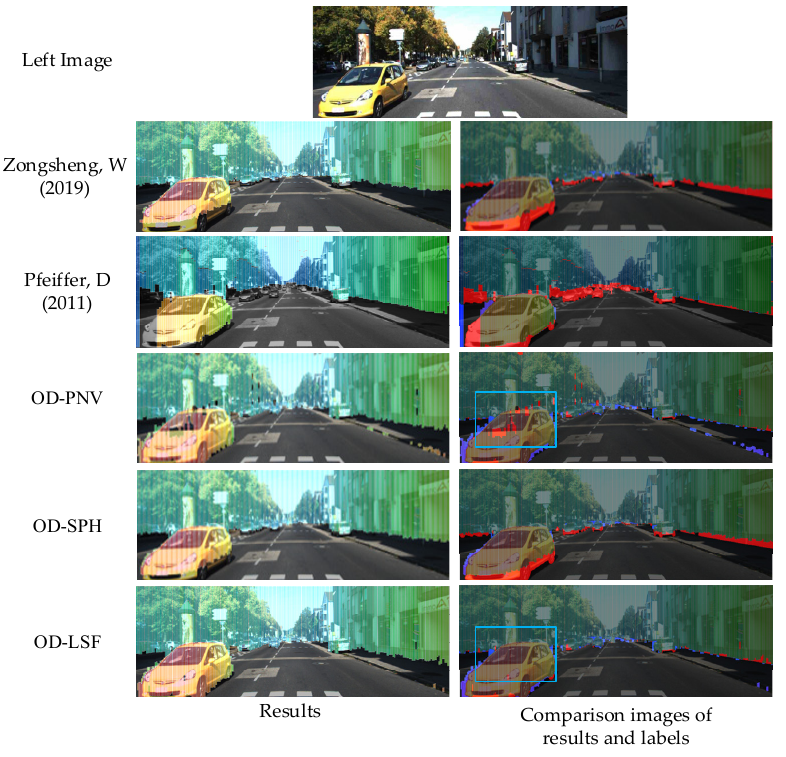
Figure 16. Scene 3 obstacle detection results. Zongsheng, W (2019) represents the Reference [19], Pfeiffer, D (2011) represents the Reference